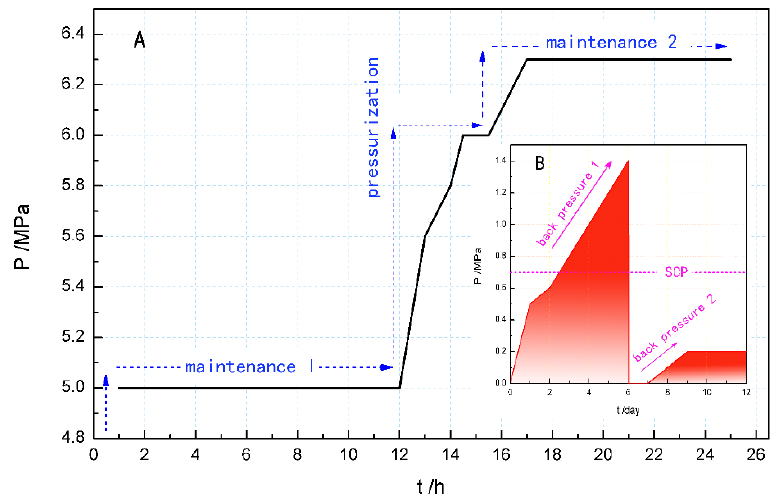
Figure 10. Pressure variation in the A annuli treated with the composite pressure-activated sealant. ( A ) Pressure build-up process, and ( B ) back-pressure process.